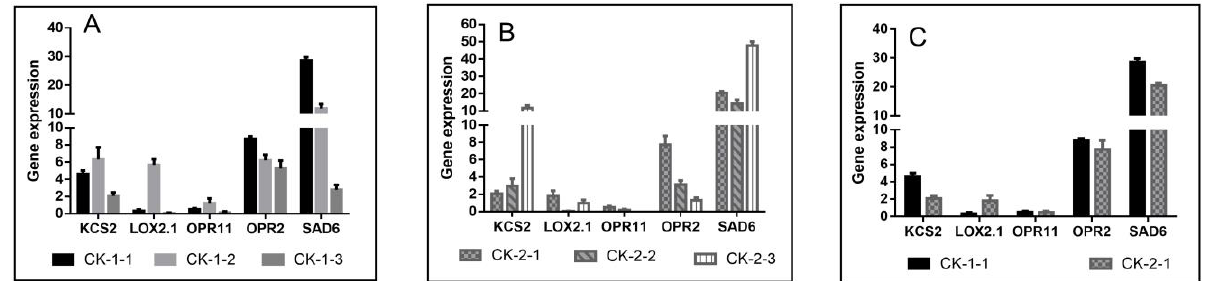
Figure 7. Expression of genes related to lipid metabolism. ( A ): Expression of common DEGs related to lipid metabolism at three time points under − 10 ◦ C treatment (CK-1-1 vs. CK-1-2 vs. CK-1-3); ( B ): Expression of common DEGs related to lipid metabolism at three time points under − 16 ◦ C treatment (CK-2-1 vs. CK-2-2 vs. CK-2-3); ( C ): Expression of common DEGs related to lipid metabolism at different temperatures for 3h (CK-1-1 vs. CK-2-1).